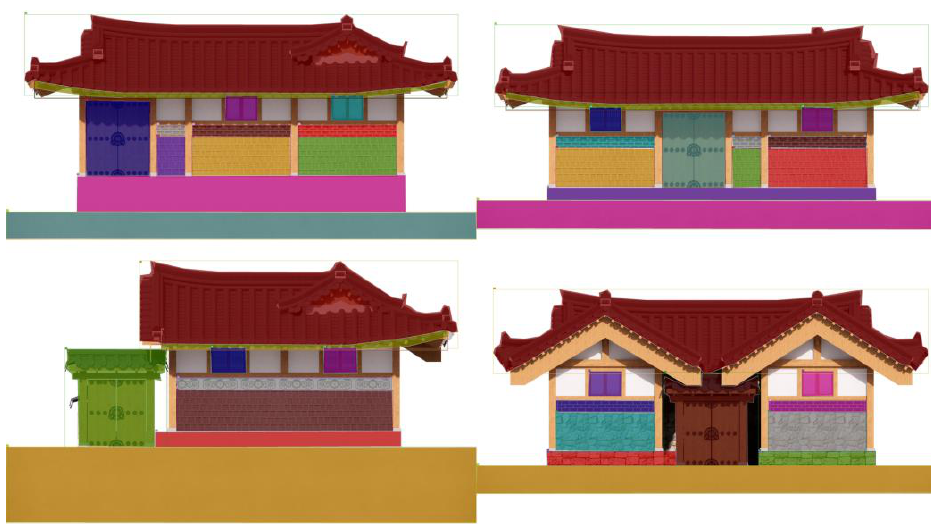
Figure 15. Visualization of labeled examples.